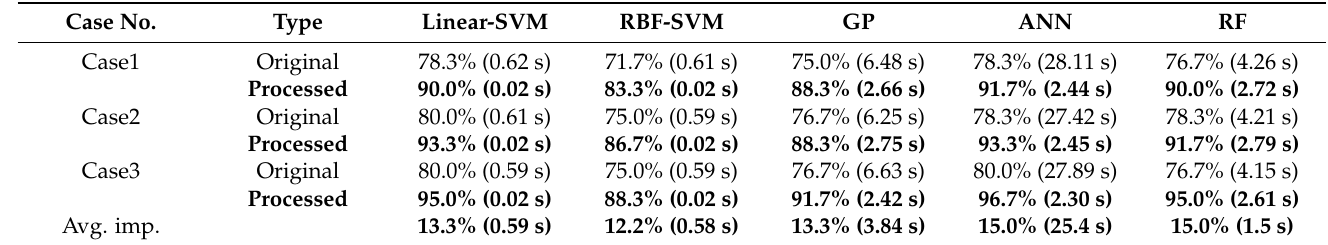
Table 3. Comparison results of accuracy and